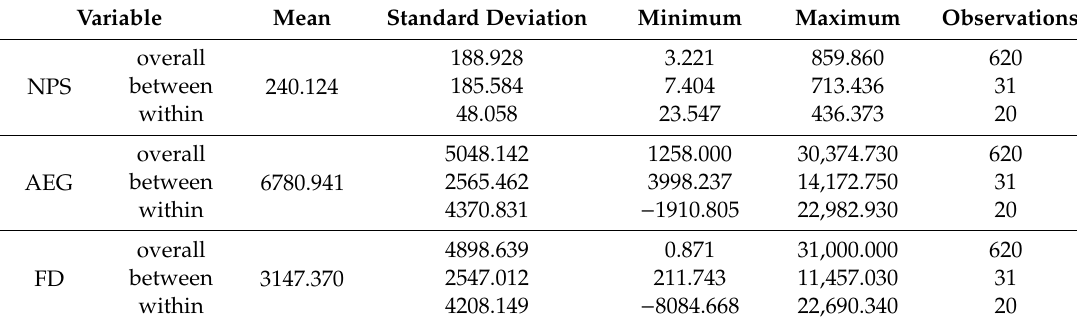
Table 1. Variable descriptive